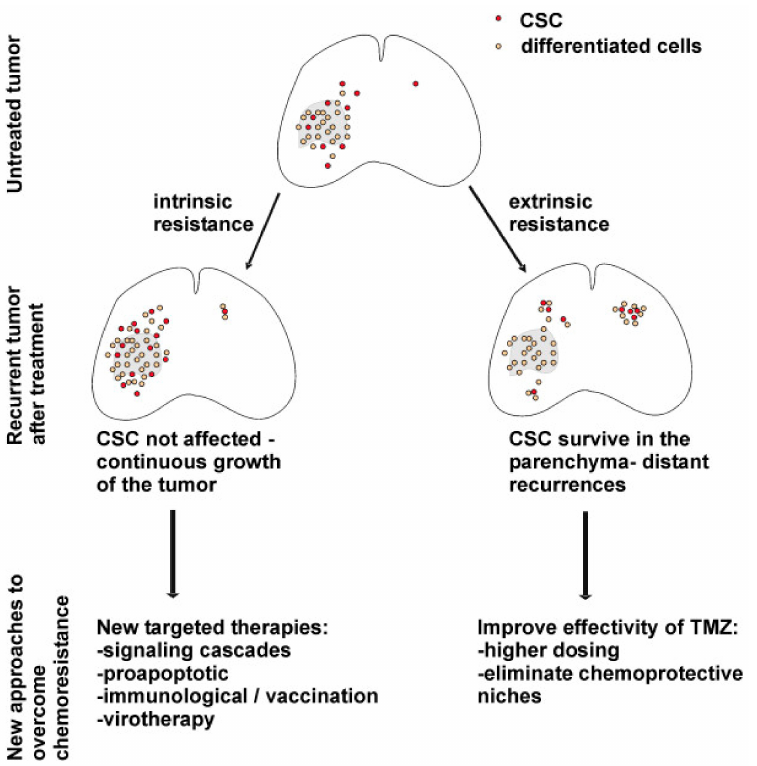
Figure 3. Behavior of GSCs, processes in the tumor in the context of intrinsic and extrinsic mechanisms of chemotherapy resistance and possible therapeutic strategies to overcome it [93]. License of this figure provided at https://creativecommons.org/licenses/by/2.0/ (accessed on 19 February 2021). Changes made: figure